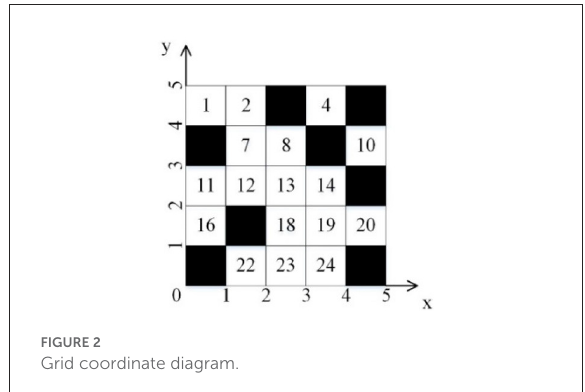
The coordinate form of the grid map is shown in Figure